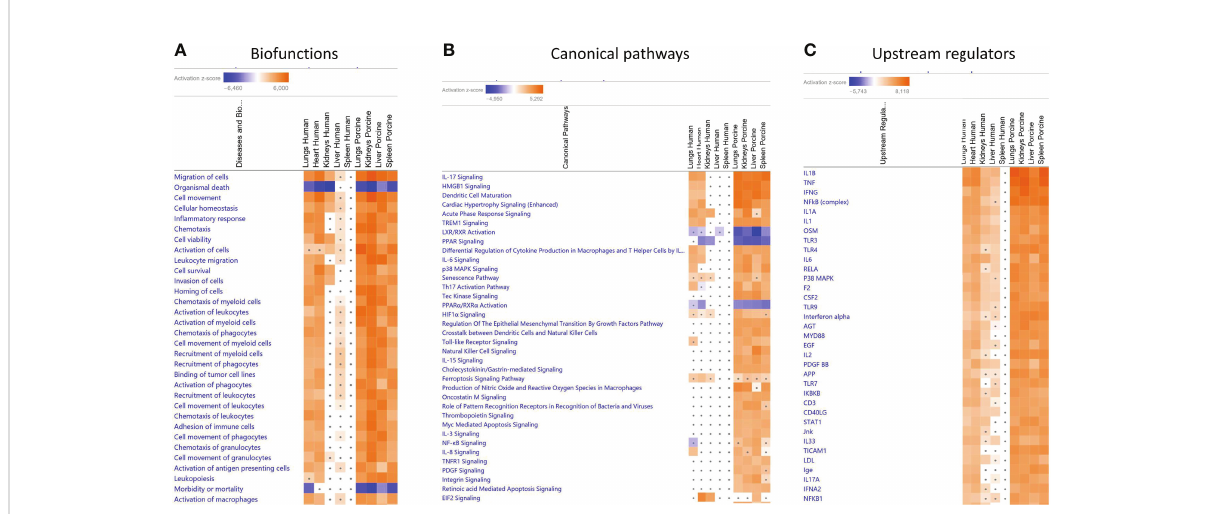
FIGURE 1 Predicted biofunctions (A) , canonical pathways (B) , and upstream regulators (C) in FFPE tissue samples from patients with meningococcal septic shock and in organs from porcinis infused with exponentially increasing numbers of N. meningitidis (reference strain H44/76) vs. controls. ≪ Comparison analysis ≫ of biofunctions (A) , canonical pathways (B) , and upstream regulators (C) , signi fi cantly enriched in FFPE tissue samples from lungs, heart, kidneys, liver, and spleen from meningococcal septic shock patients vs. control patients (acute non-infectious death) and in FF tissue samples from lungs, kidneys, liver and spleen from porcinis infused with exponentially increasing numbers of N. meningitidis (reference strain H44/76) vs. controls was performed. The fi gure shows the most upregulated biofunctions (A) , canonical pathways (B) , and upstream regulators (C) ranked according to expression levels in FFPE tissues from lungs. The Z-score indicates predicted activation state of the biofunctions, canonical pathways, and upstream regulators. Z-score values >| ± 2| are displayed. Dots display insigni fi cant threshold Z-score values <± 2|. Blue color or lighter shades of blue indicate a negative Z-score and downregulation of a biofunction, canonical pathways, and upstream regulators. Orange or lighter shades of orange indicate a positive Z-score and upregulation of a biofunction, canonical pathways, and upstream regulators. Note that only the top pathways are